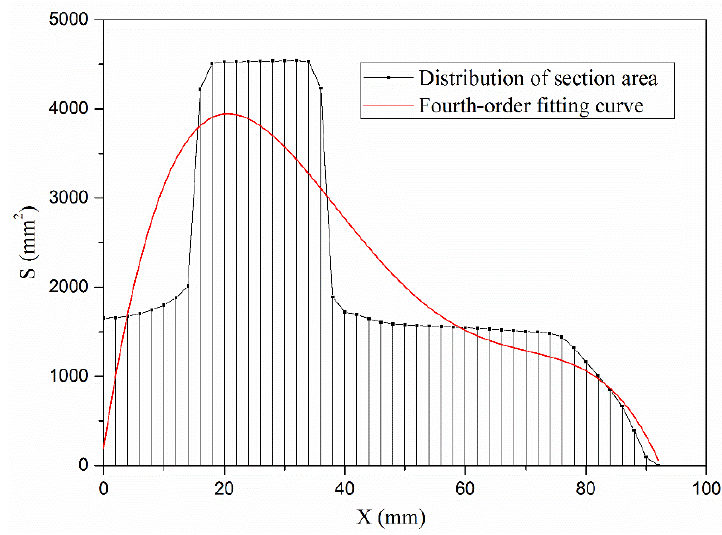
Figure 9. Transverse distribution curve of X section area.